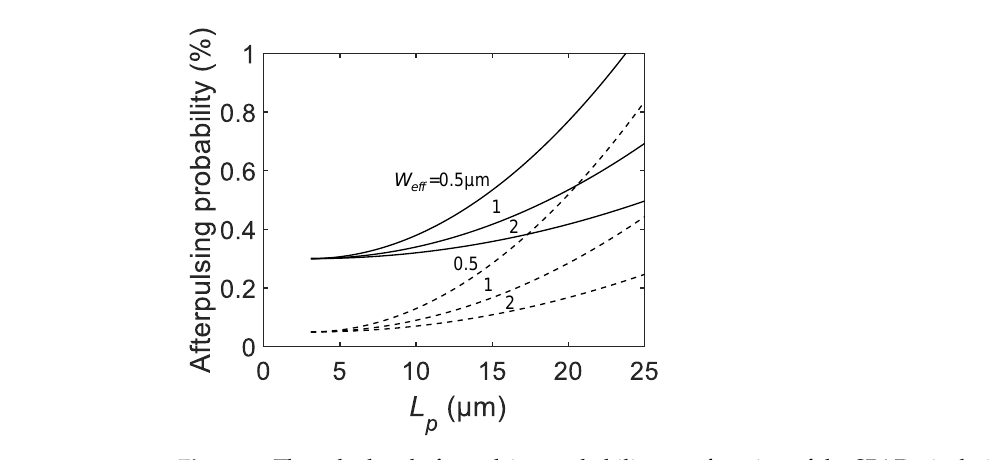
Figure 7. The calculated afterpulsing probability as a function of the SPAD pixel pitch L p for C 0 = 5 fF (dashed lines), and 30 fF (solid lines), active-to-active distance L a − a = 3 µ m, A = 1 × 10 11 F − 1 , and W ef f = 0.5, 1, 2 µ